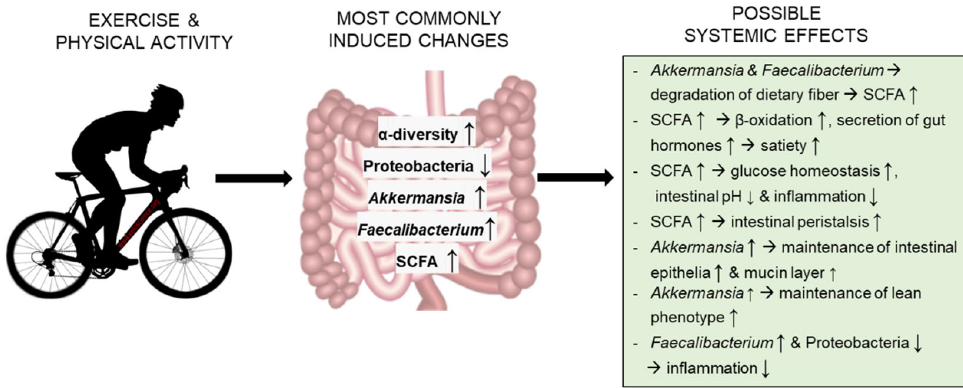
Figure 2. The most reproducible findings from the longitudinal exercise studies, and hypotheses of their effects on the host. Abbreviations: SCFA, short ‐ chain fatty